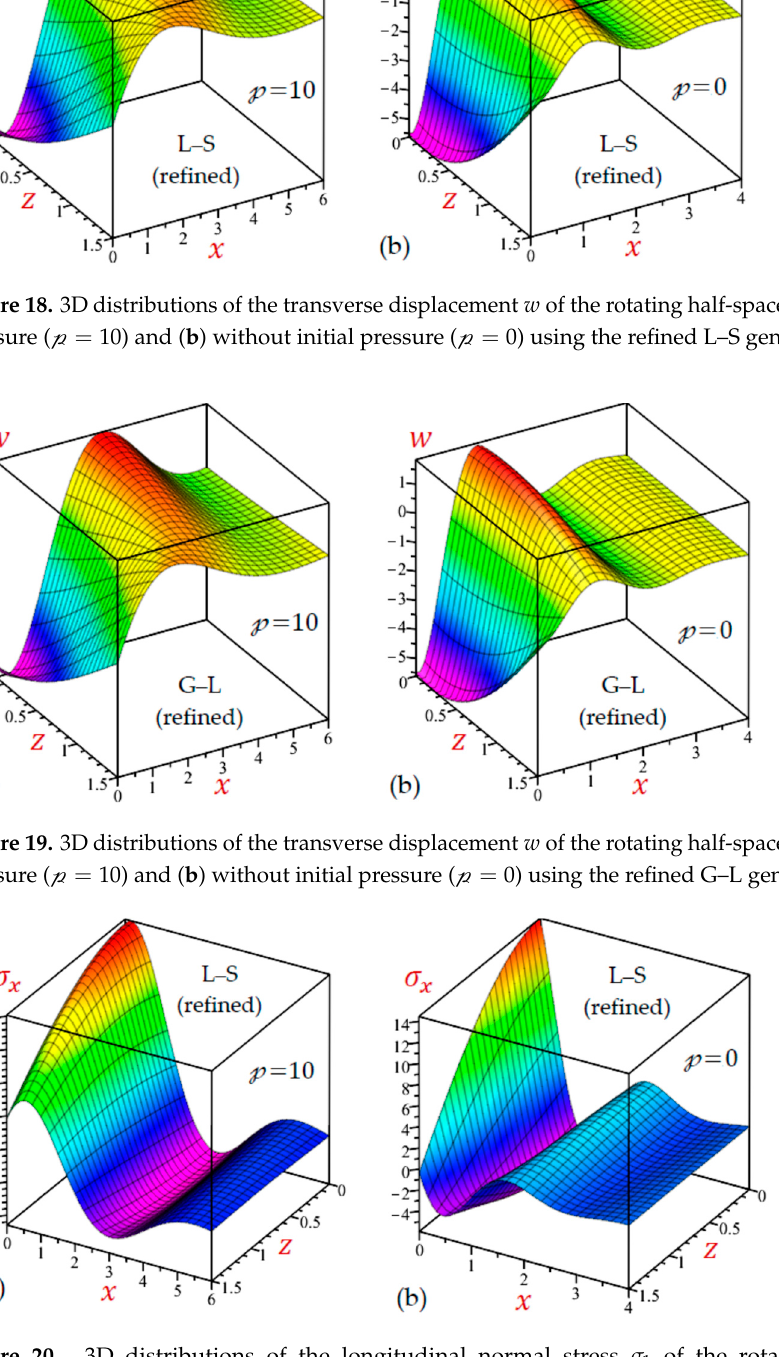
Figure 20. 3D distributions of the longitudinal normal stress σ 1 of the rotating half-space: